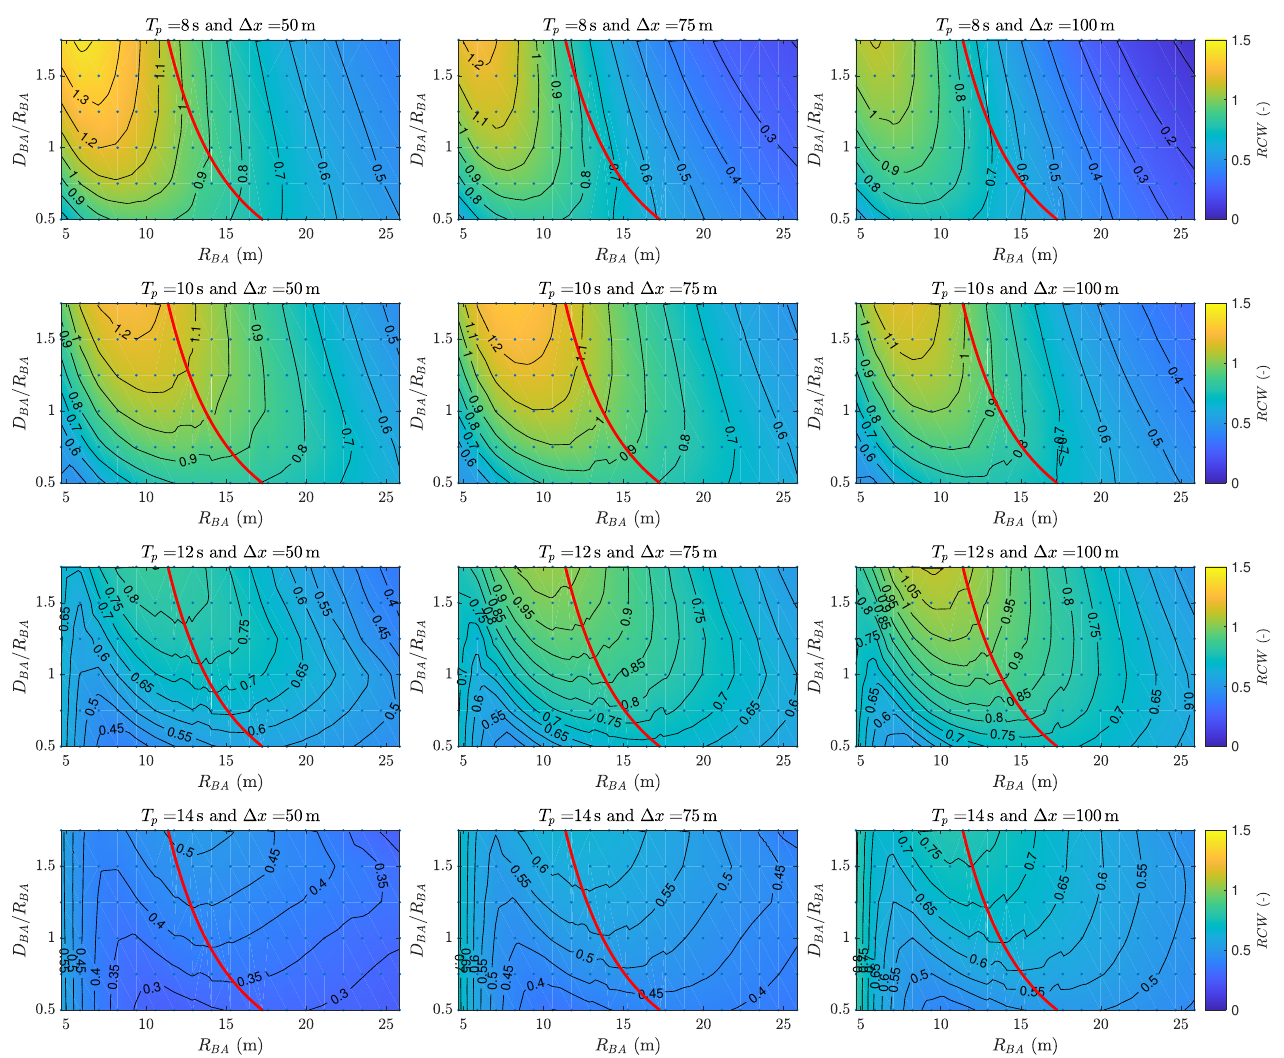
Figure 5. As in Figure 3 but for the relative capture width instead of the power generated.